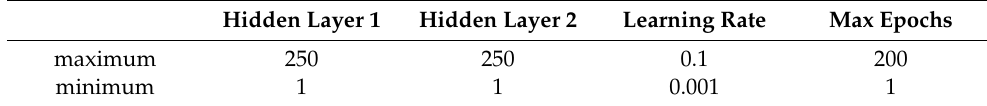
Table 2. Limited conditions of optimized parameters for QPSO–BiLSTM.